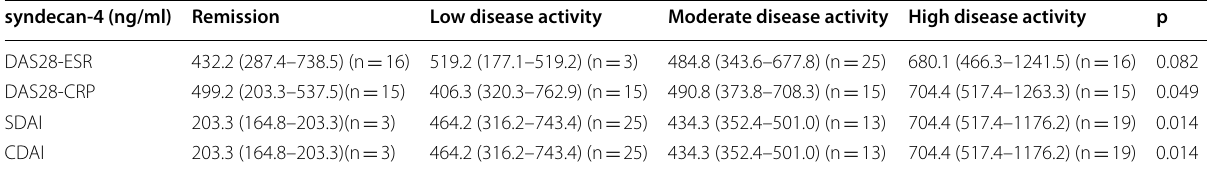
RA rheumatoid arthritis, ESR erythrocyte sedimentation rate, CRP C-reactive protein, DAS disease activity score, SDAI simple disease activity index, CDAI clinical disease activity index